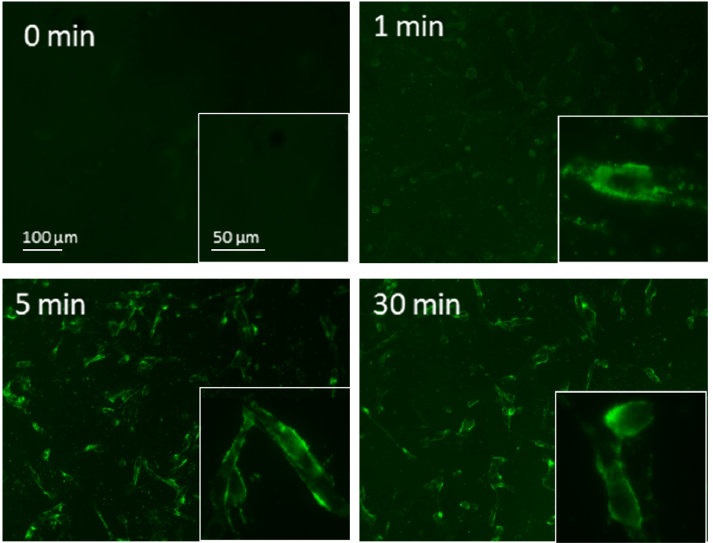
Figure 3. Fluorescent images of 6-coumarin-NB uptake in M14 cells at the indicated times. Green fluorescence of 6-coumarin was examined by using fluorescence microscopy (454 nm).